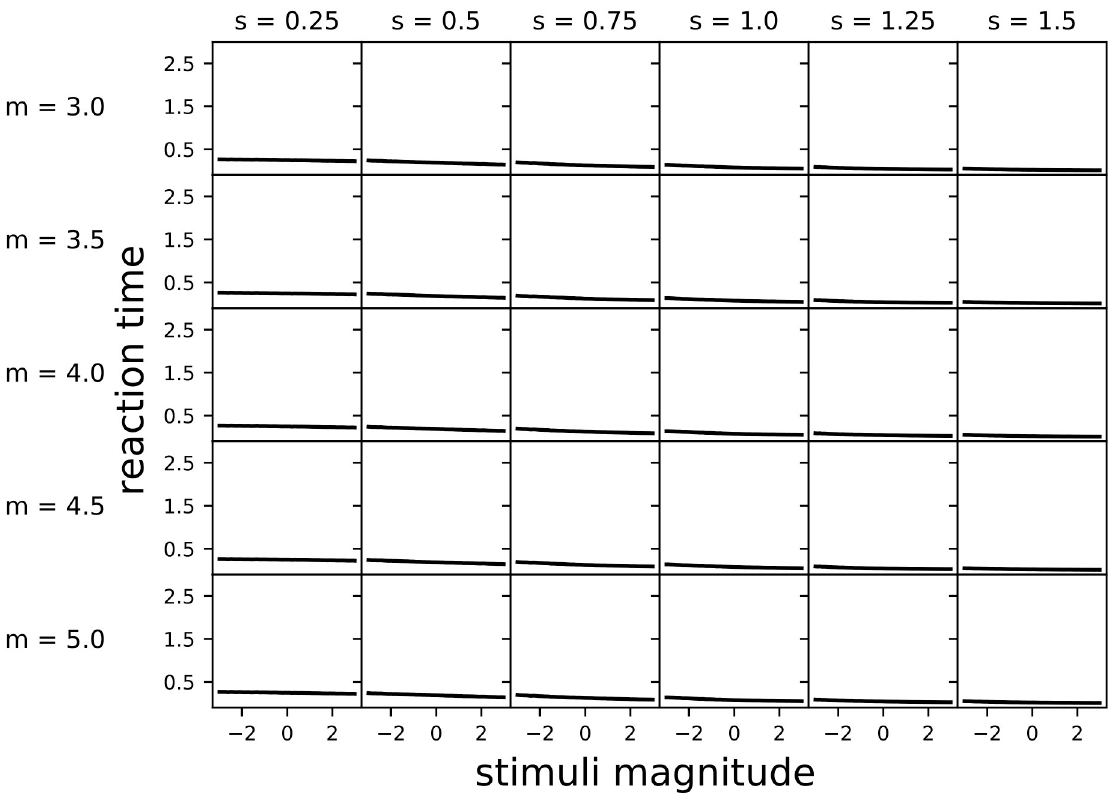
Fig 5. Linear time costs lead to weakly magnitude-sensitive simulated reaction times across a range of nonlinear subjective utility functions for equal value option sets. Simulation parameters were: prior mean � x ¼ 1 : 5 and variance s 2 ¼ 5 , observation noise variance p ; i p ; i s 2 ¼ 2 , temporal cost c = 0, waiting time t = 1, and simulation timestep dt = 5 × 10 − 3 . Lines are the mean reaction time for 10 4 w a ; i simulations, 95% confidence intervals are shown as red shading (mostly invisible because smaller than the linewidth). Y-axis made consistent with Fig 6 for comparison. Non-decision time was implicitly zero.